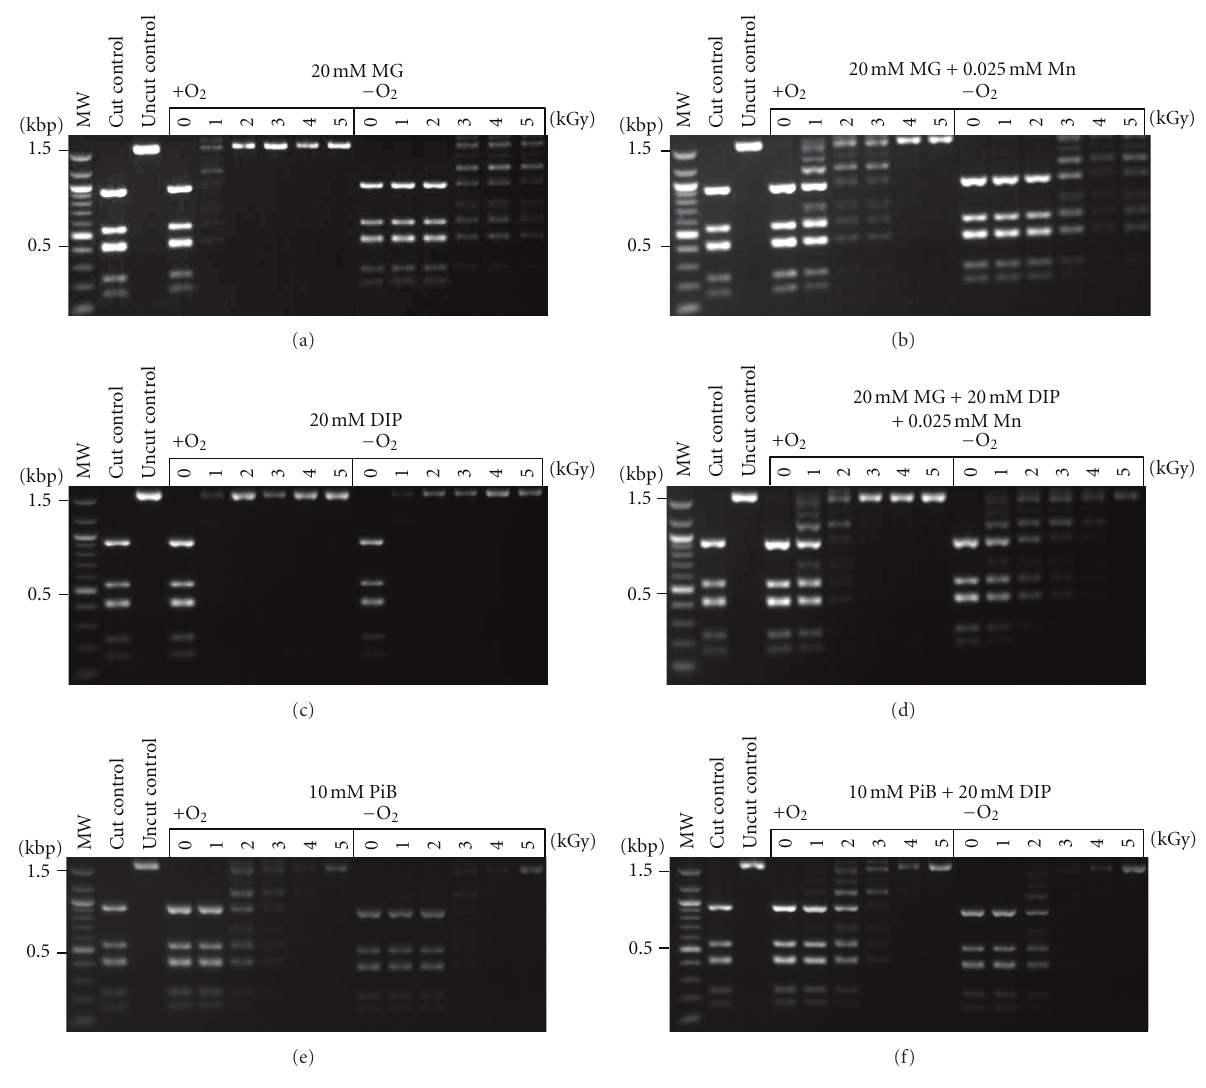
Figure 4: Protection of enzyme activity with compatible solutes. The restriction enzyme Dde I was irradiated up to 5 kGy in the presence or absence of oxygen, in water or with the addition of 20mM MG, 20mM MG and 0.025 mM Mn, 20 mM DIP, or 20mM MG, 20mM DIP, and 0.025 mM Mn. The 20mM solution of DIP had a pH of 9.5; thus 10 mM PiB was added for a final pH of 7.5. Residual restriction enzyme activity was assayed by the digestion of pUC19 plasmid DNA; fragments were analyzed by agarose gel electrophoresis. The first lanes are molecular size